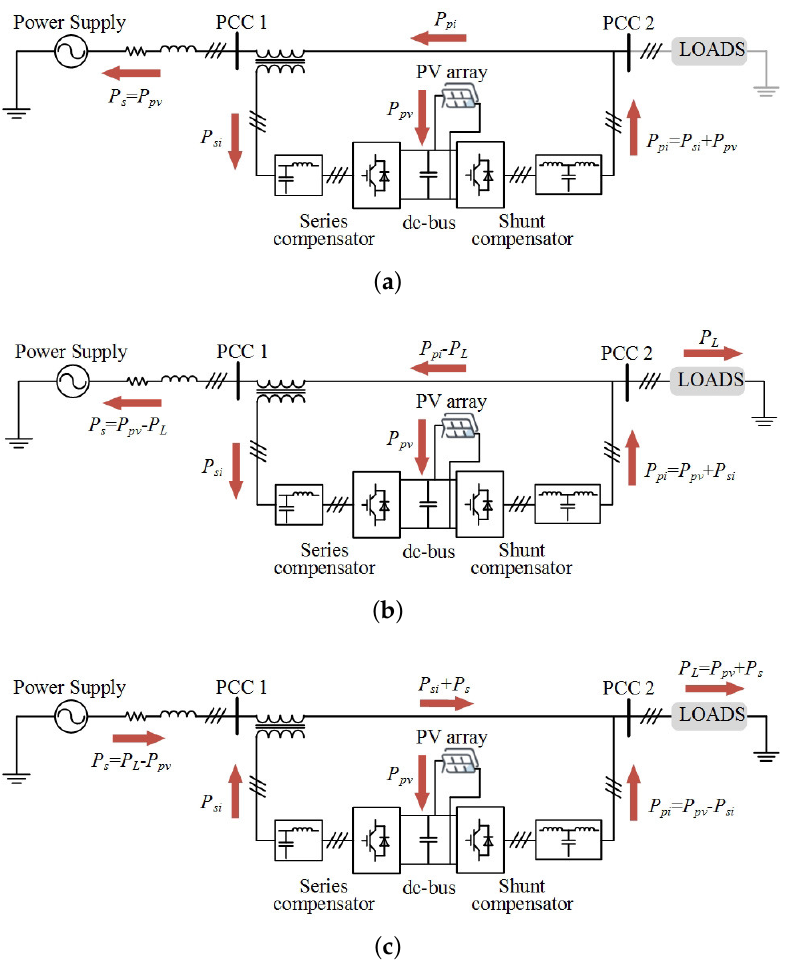
Figure 6. Active power flow through the proposed system under voltage sags. ( a ) V s < V L with P L = 0, ( b ) V s < V L with P L < P pv , and ( c ) V s < V L with P L > P pv